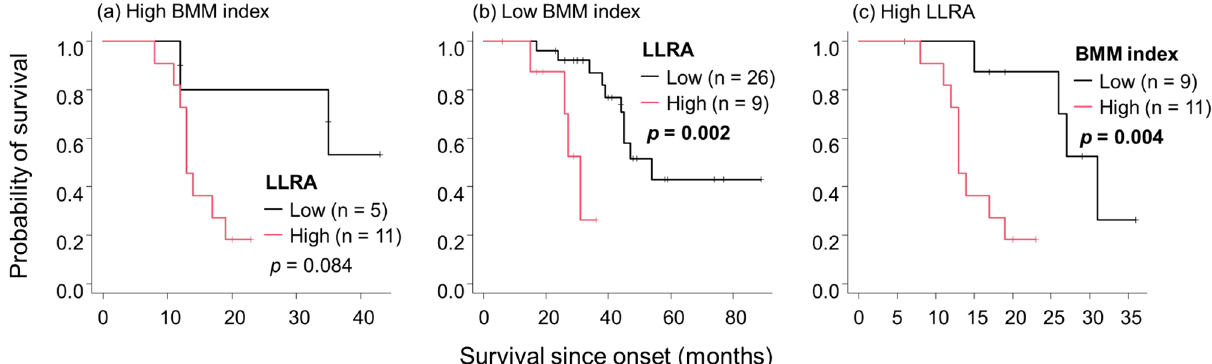
Figure 5. The relationship between the BMM index and LLRA in terms of survival. In the high BMM index group, patients with high LLRA had shorter survival than those with low LLRA although the difference was not significant ( a ), whereas the difference was significant in the low BMM index group ( b ). In the high LLRA group, patients with a high BMM index had significantly shorter survival than those with a low BMM index